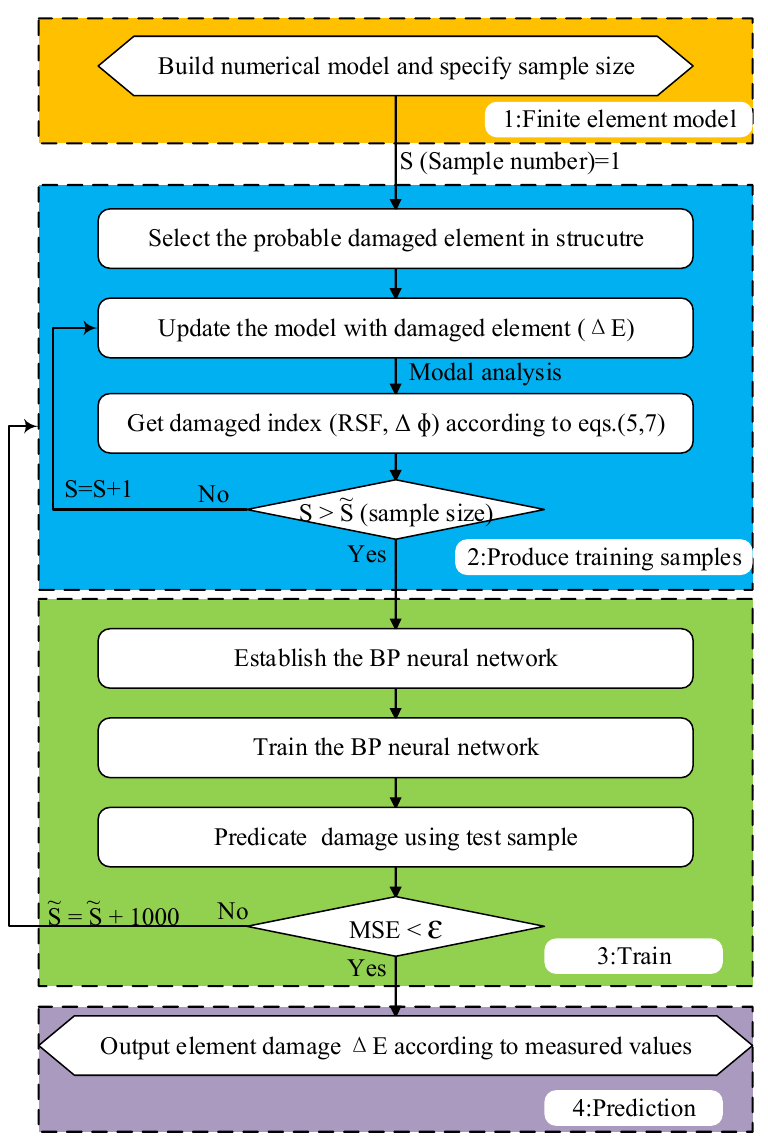
Figure 3. Analysis flowchart; (MSE: Mean Squared Error).